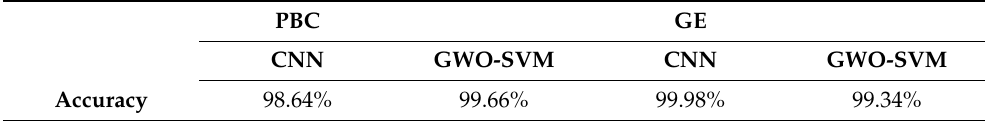
Table 10. Comparison between the proposed models and the DL-based model. PBC